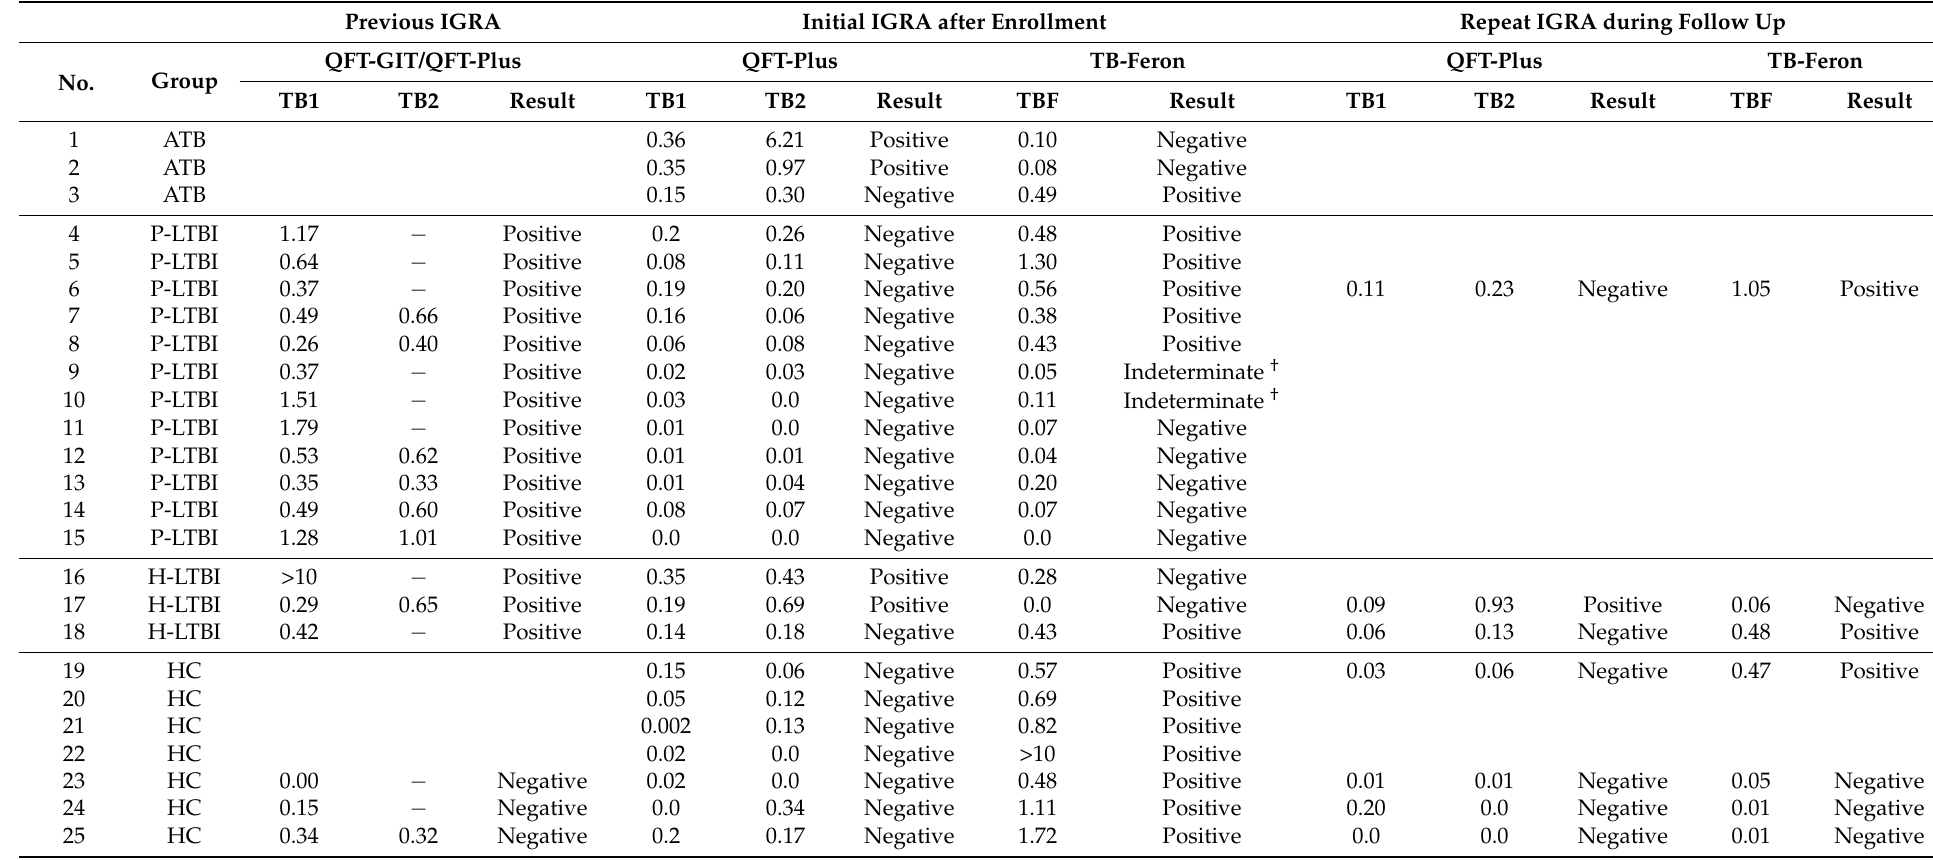
Table 3. Results of IGRAs in 25 cases with discordant results between QFT-GIT/QFT-Plus and TB-Feron tests. Previous IGRA Initial IGRA after Enrollment Repeat IGRA during Follow